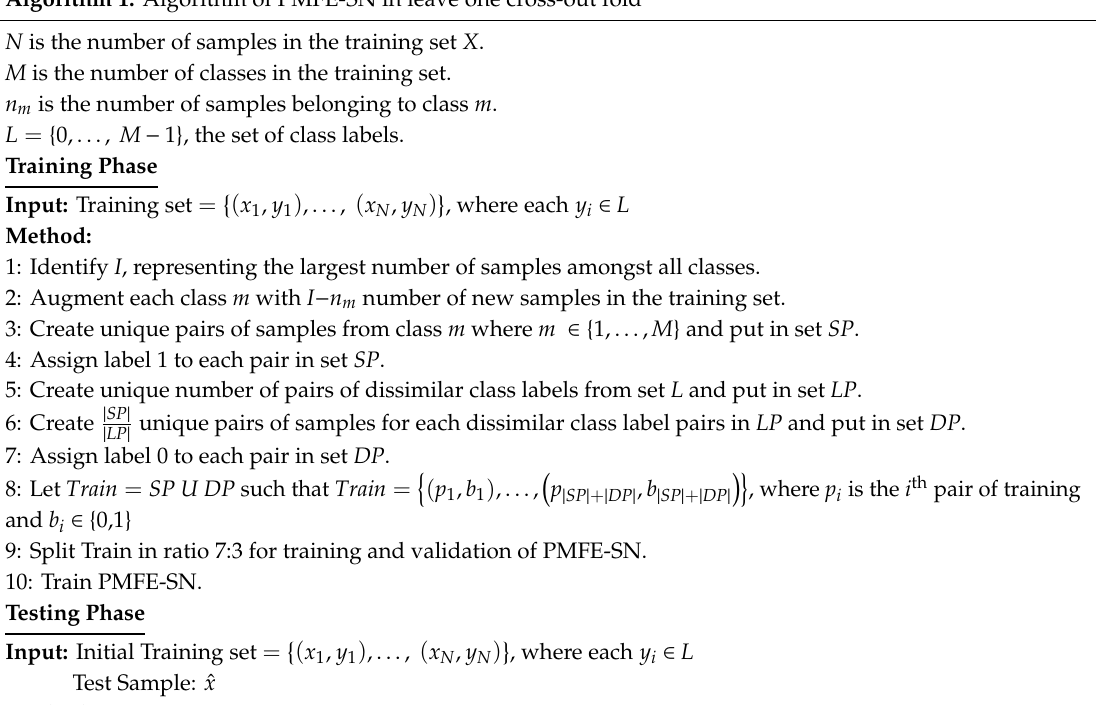
Algorithm 1. Algorithm of PMFE-SN in leave one cross-out fold N is the number of samples in the training set X . M is the number of classes in the training